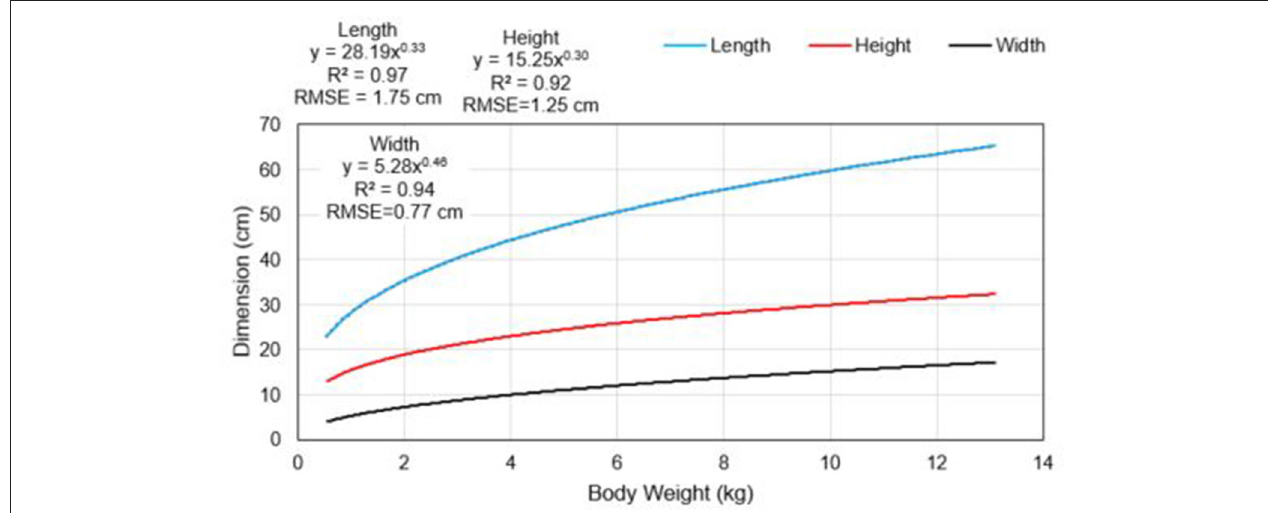
FIGURE 1 | Dimension data (y axis) vs. body weight (x axis) from birth to weaning for all piglets in the study.